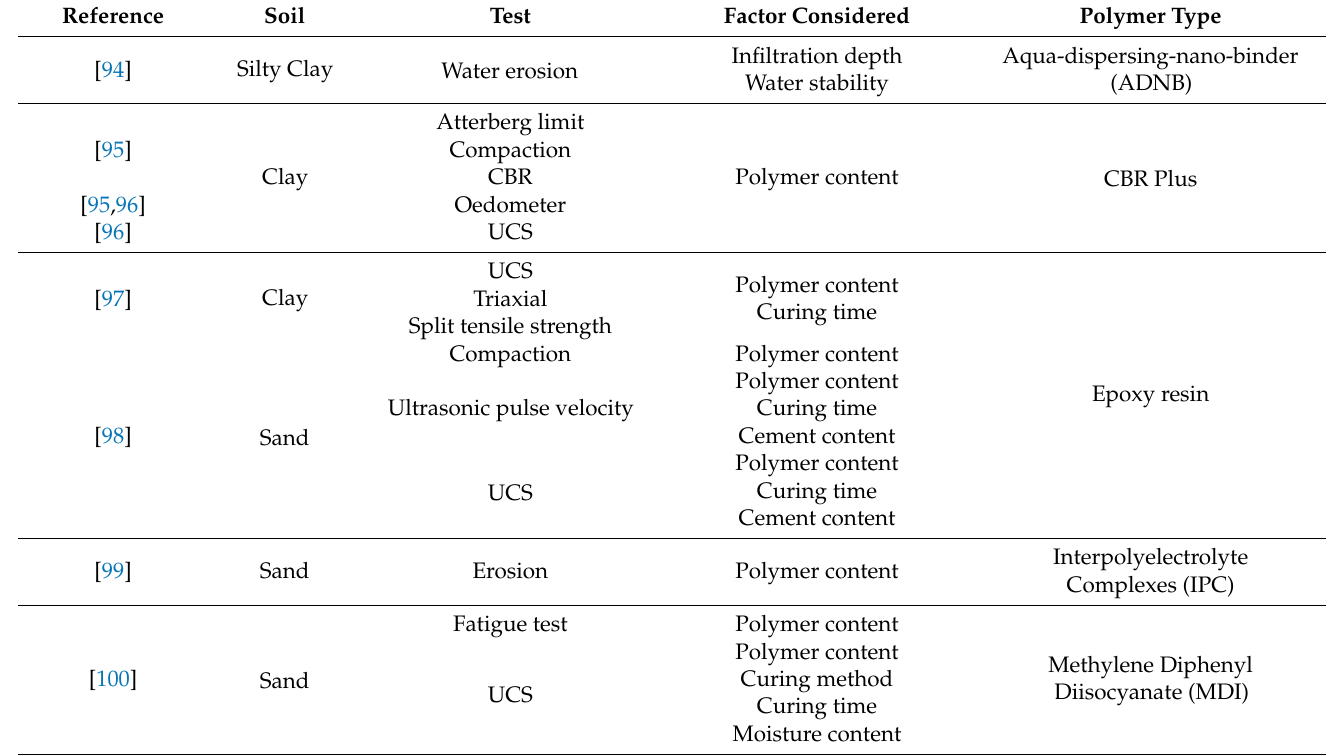
Table 1. Summary of polymer used to improve geotechnical properties of